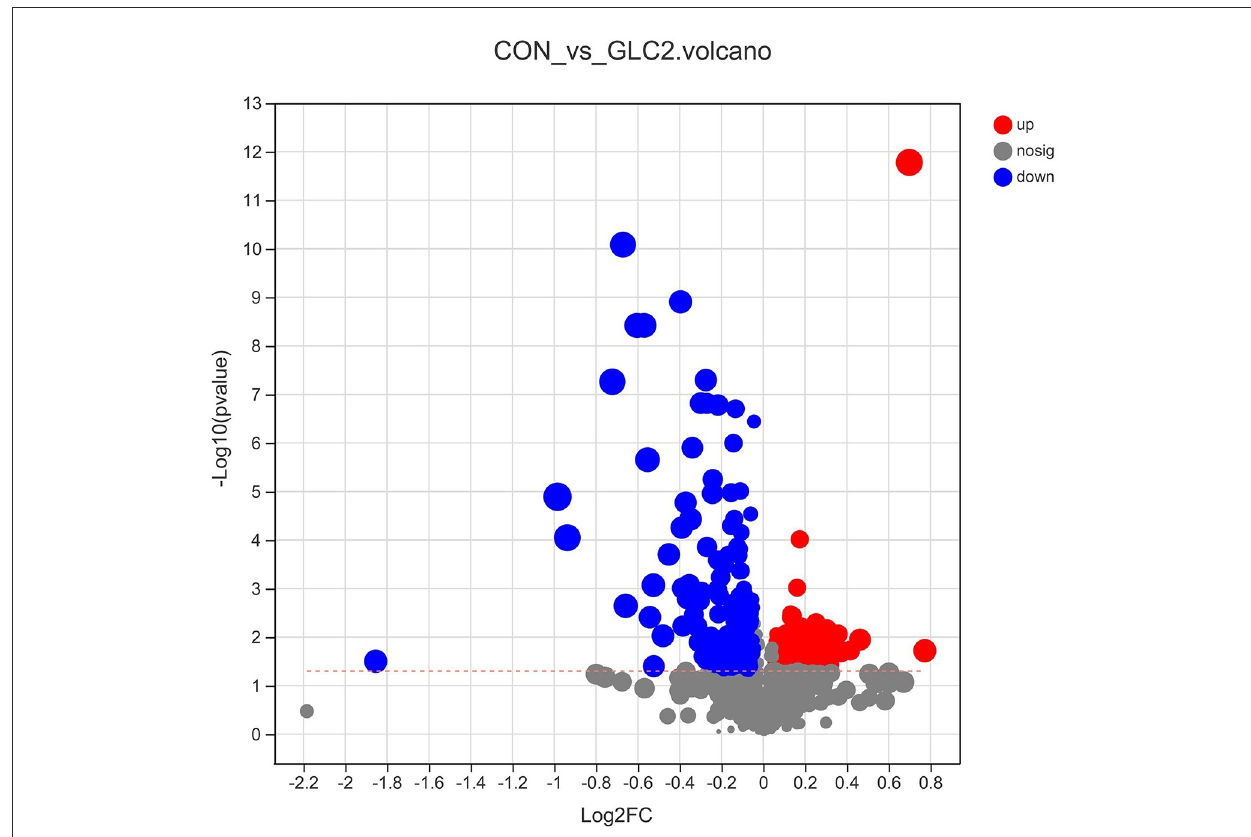
FIGURE9 Effect of Ganoderma lingzhi culture (GLC) supplementation on volcano plot analysis of the caecal metabolites ( n = 6; CON, control diet; GLC 2: 3% GCL diet).